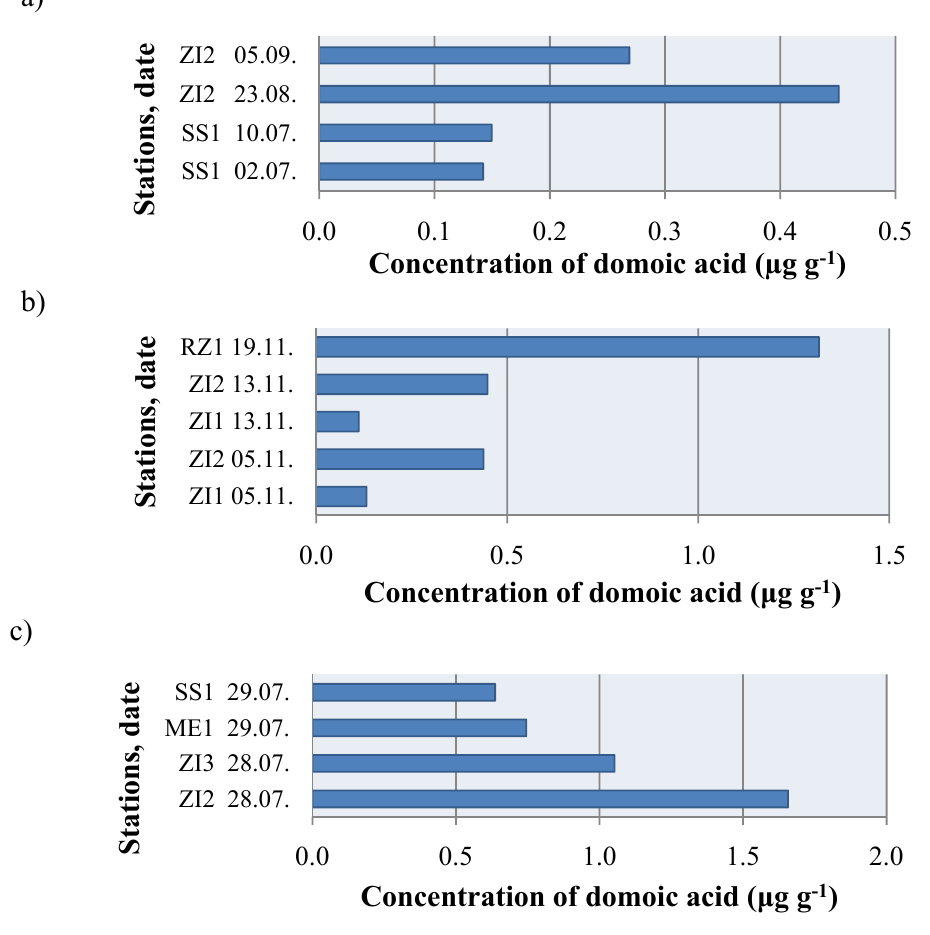
Figure 5. Domoic acid in shellfish samples Mytilus galloprovincialis (SS1, RZ1 and ME1) , Flexopecten proteus (ZI1), Pecten jacobaeus (ZI2) and Ostrea edulis (ZI3) from the north Adriatic Sea in (a) 2006, (b) 2007 and (c)